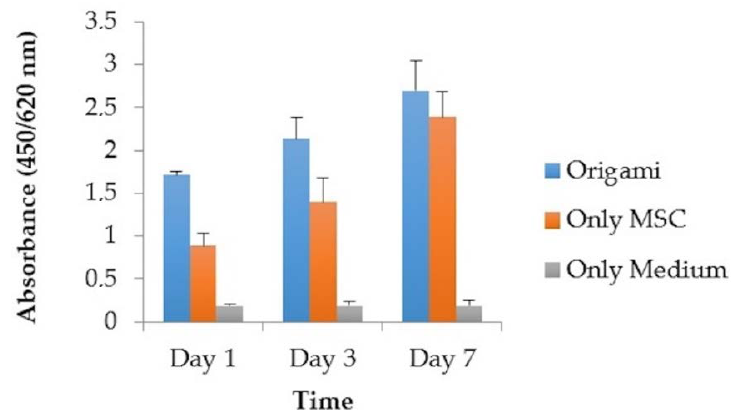
Figure 6. Cell adhesion and proliferation of the material and the control groups (Origami refers to the samples produced in the process addressed in the present article).